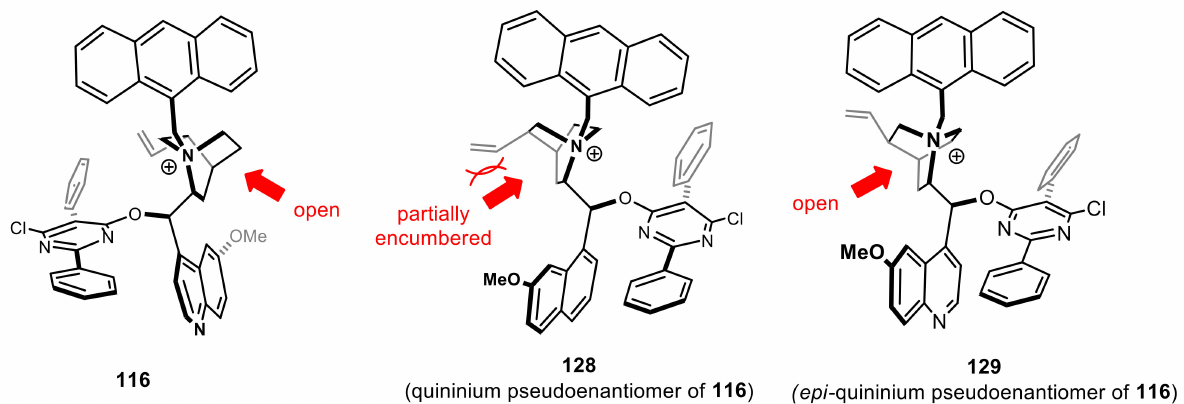
Figure 5. Three-dimensional structures of the N -anthracenyl- O -PYR quinidinium, quininium, and 3-epi-quininium cations obtained from X-ray analysis (the red arrows show the cavity which serves as a preferential coordination site for the aza-allyl